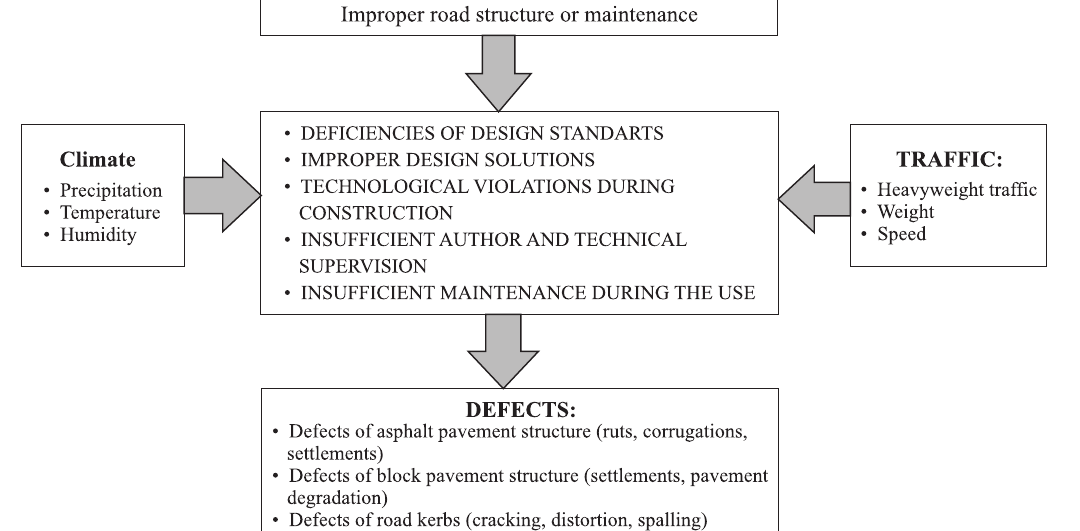
Fig. 9. Structural road defects and their causes